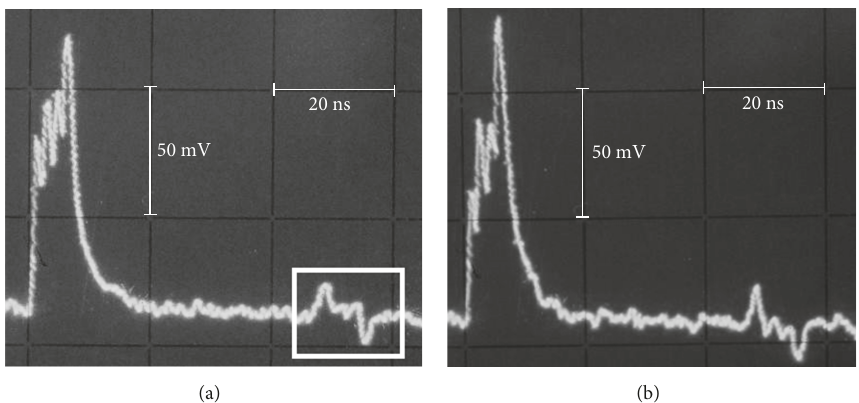
Figure 13: Waveform at the far end of the probing line ( 𝑉4 ) of the structure with a passive wire break when 𝑅2 = 𝑅4 = 100 Ω (a) and 𝑅2 = 𝑅4 = ∞ (b).